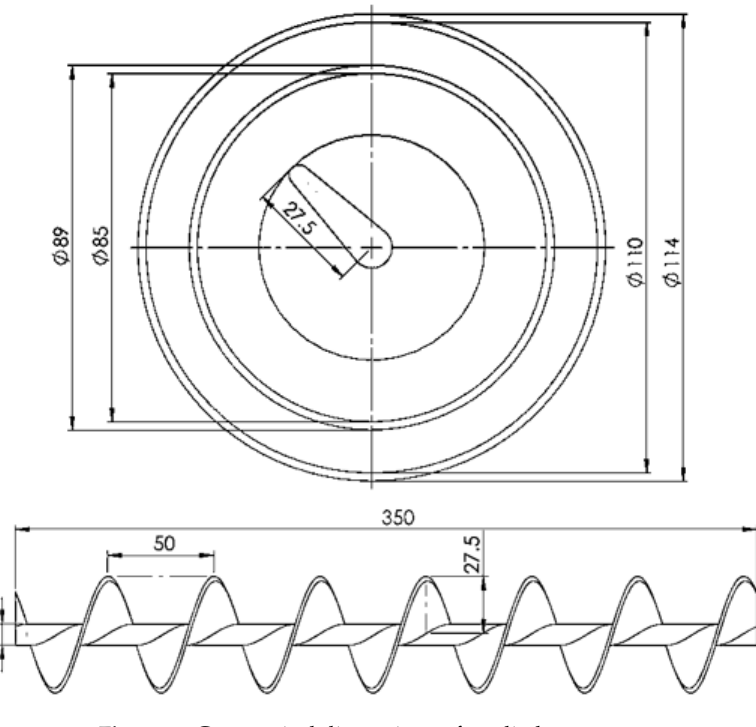
Figure 2. Geometrical dimensions of studied geometry.